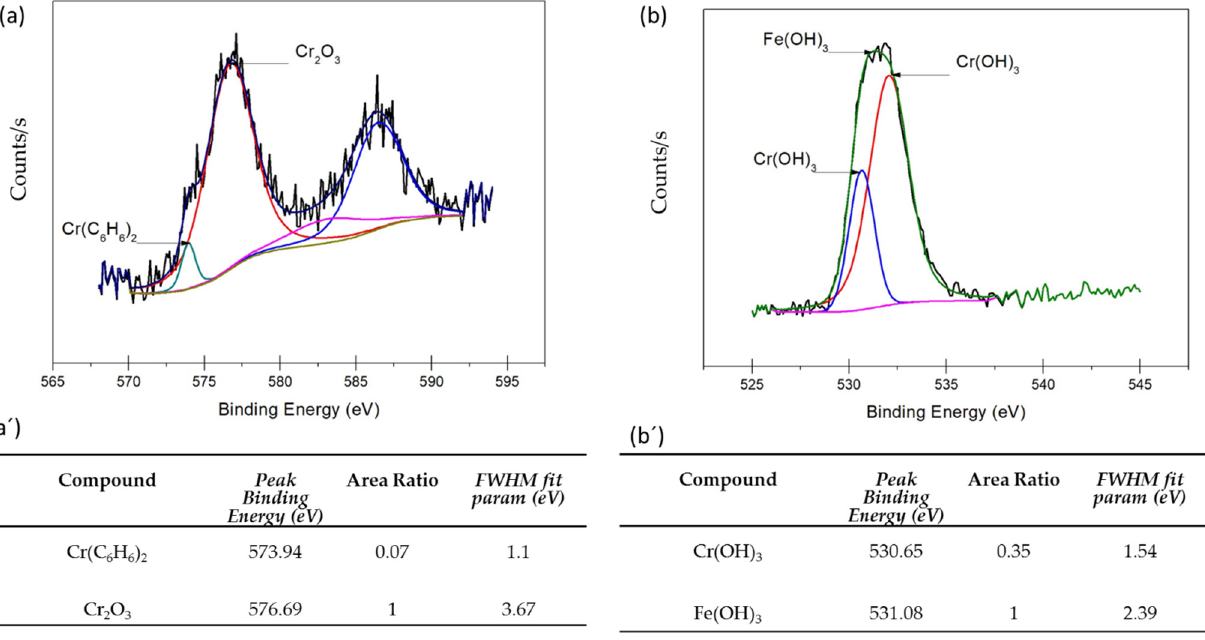
Figure 10. X-ray photoelectron spectra for CUSTOM450NA–50 min–49 °C: ( a ) Cr 2p, ( b ) O 1s. Parameters obtained: peak binding energy and FWHM fit param ( a’ ) Cr 2p, ( b’ ) O 1s.